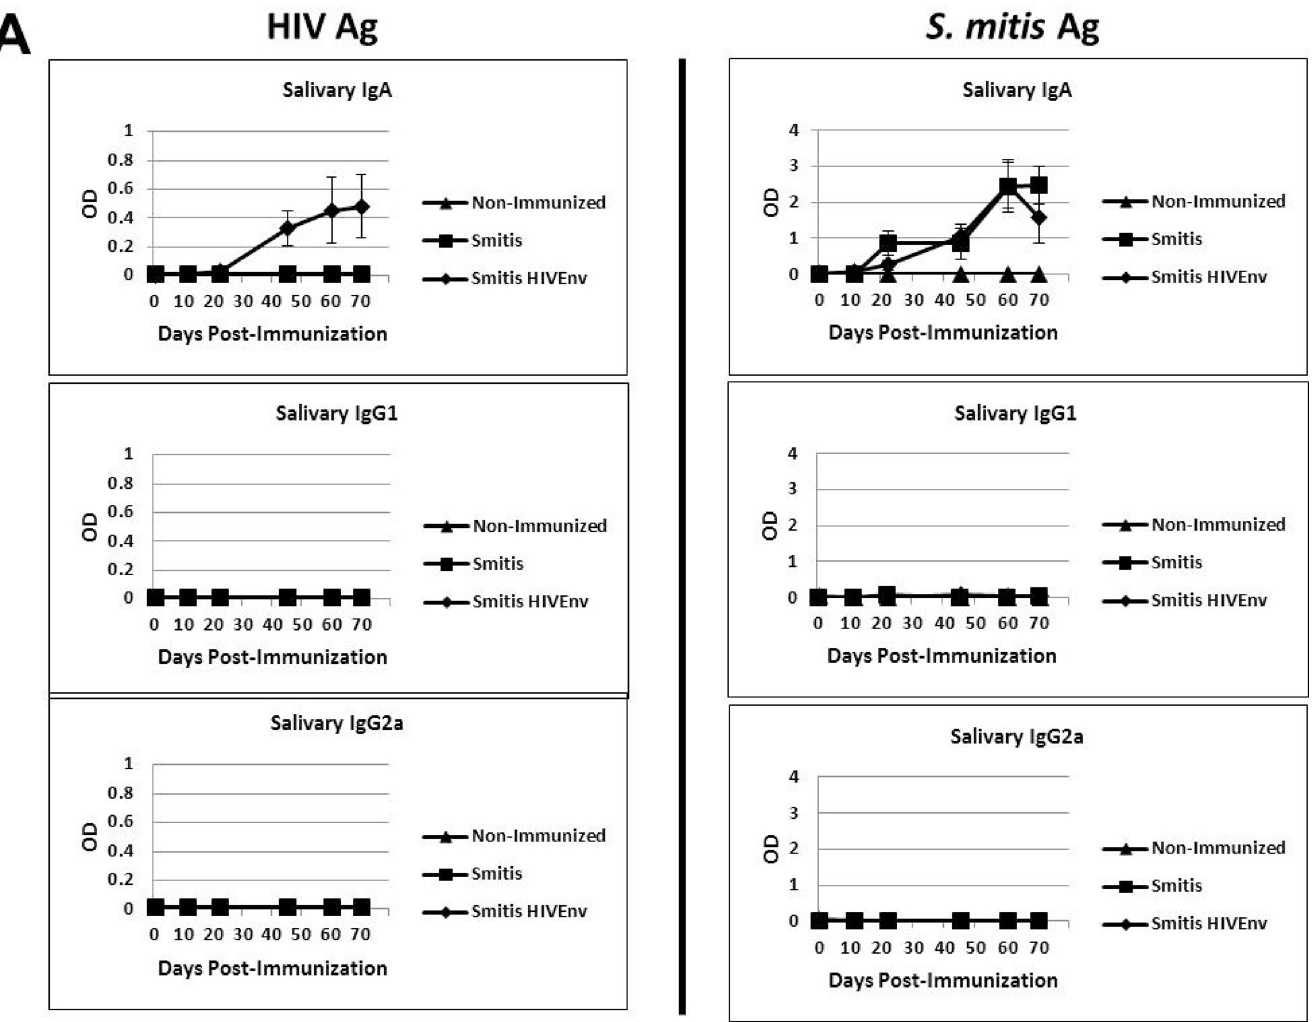
Fig 5. Recombinant S . mitis induces mucosal and systemic antibody responses. Germ-free Balb/c mice were inoculated orally with 10 9 cfu rS . mitis expressing HIV Env gp120 (Smitis HIV Env), rS . mitis containing an integrated Erm r gene without Env gp120 (Smitis), or PBS (Non-Immunized). Following immunization, the presence of IgA, IgG1, and IgG2a antibodies specific to the HIV Env gp120 protein (HIV Ag) or S . mitis lysate antigens ( S . mitis Ag) was measured by ELISA in the saliva (A) and serum (B) of mice. The mean optical density (OD) ( ± SEM) values of the undiluted samples from 3 mice/group at various timepoints post-immunization are shown. The saliva and serum antibody dilution factor was 1:3 or indicated